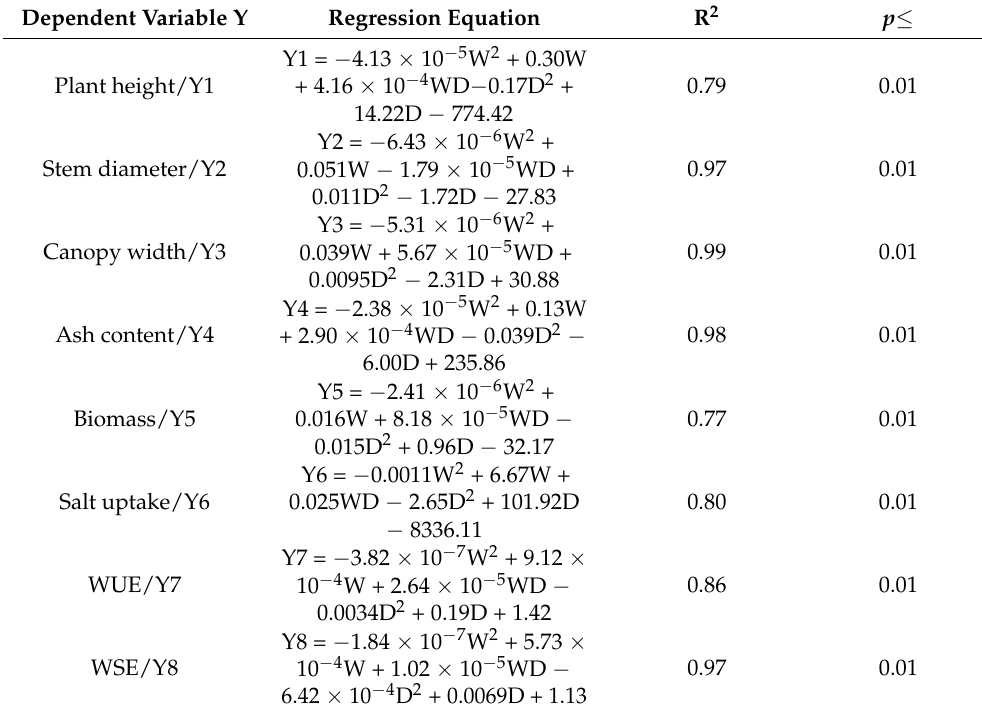
Table 7. Multiple regression relationships between irrigation, density, and each evaluation indicator.